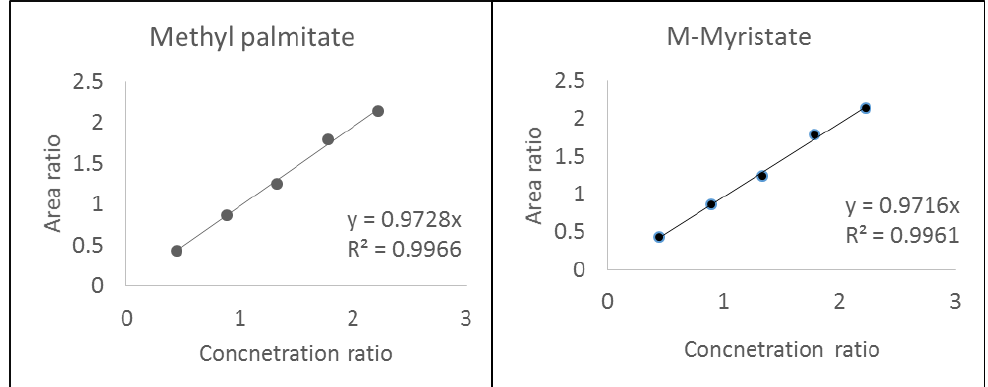
Figure A2. Calibration curves of methyl-palmitate and methyl-myristate.